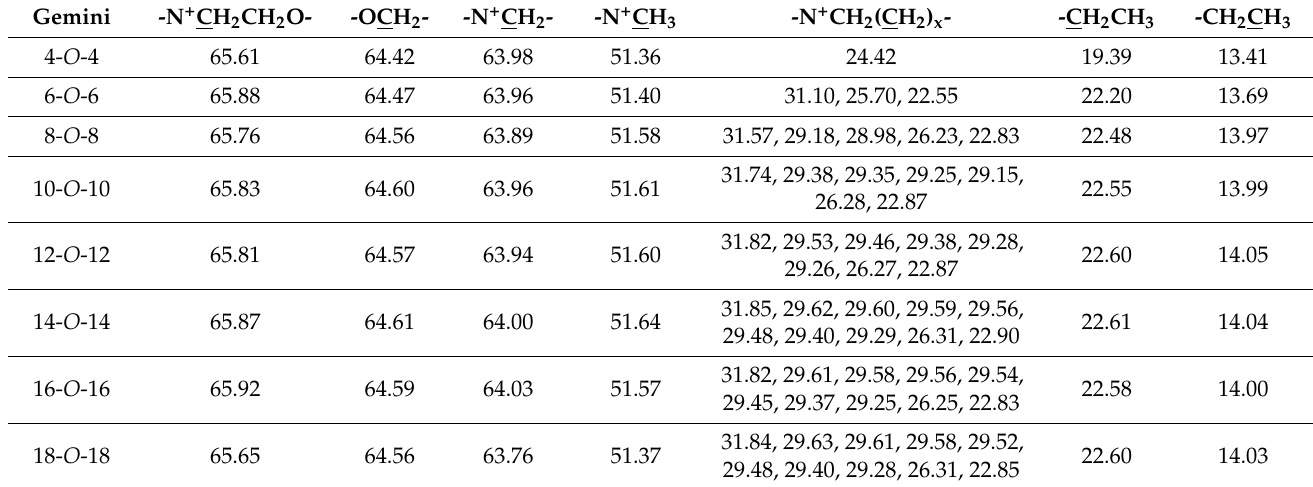
Table 2. Carbon chemical shifts from 13 C NMR spectra of gemini surfactants ( n - O - n )